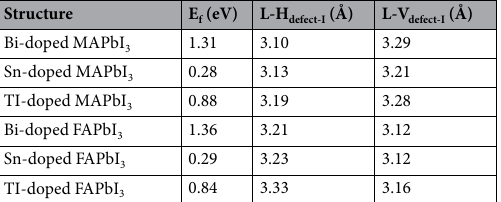
Table 1. The formation energies and detailed defect-I bond lengths of cation-doped MAPbI 3 /FAPbI 3 . Where the E f , L-H defect-I , and L-V defect-I are the formation energies, the average defect-I bond lengths in the horizontal surface of defect-I octahedral structure and the average defect-I bond lengths in the vertical direction of defect-I octahedral structure, respectively.